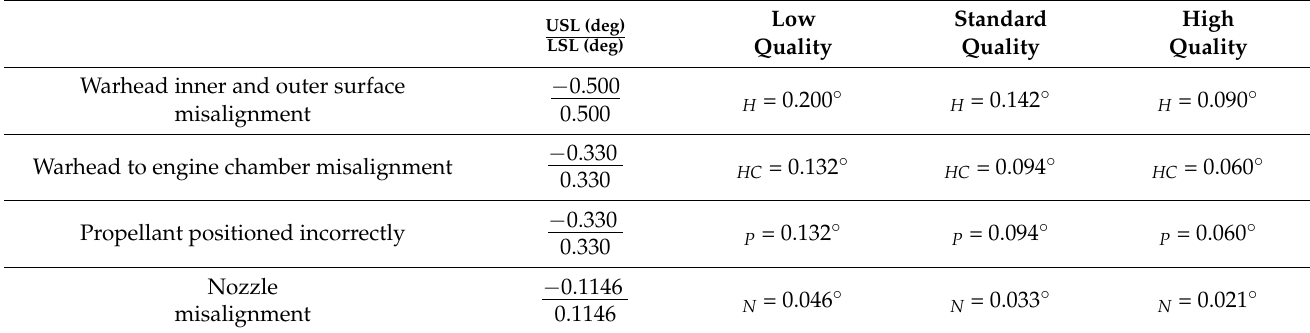
Table 2. Standard deviations for simulated errors, according to the chosen quality level.